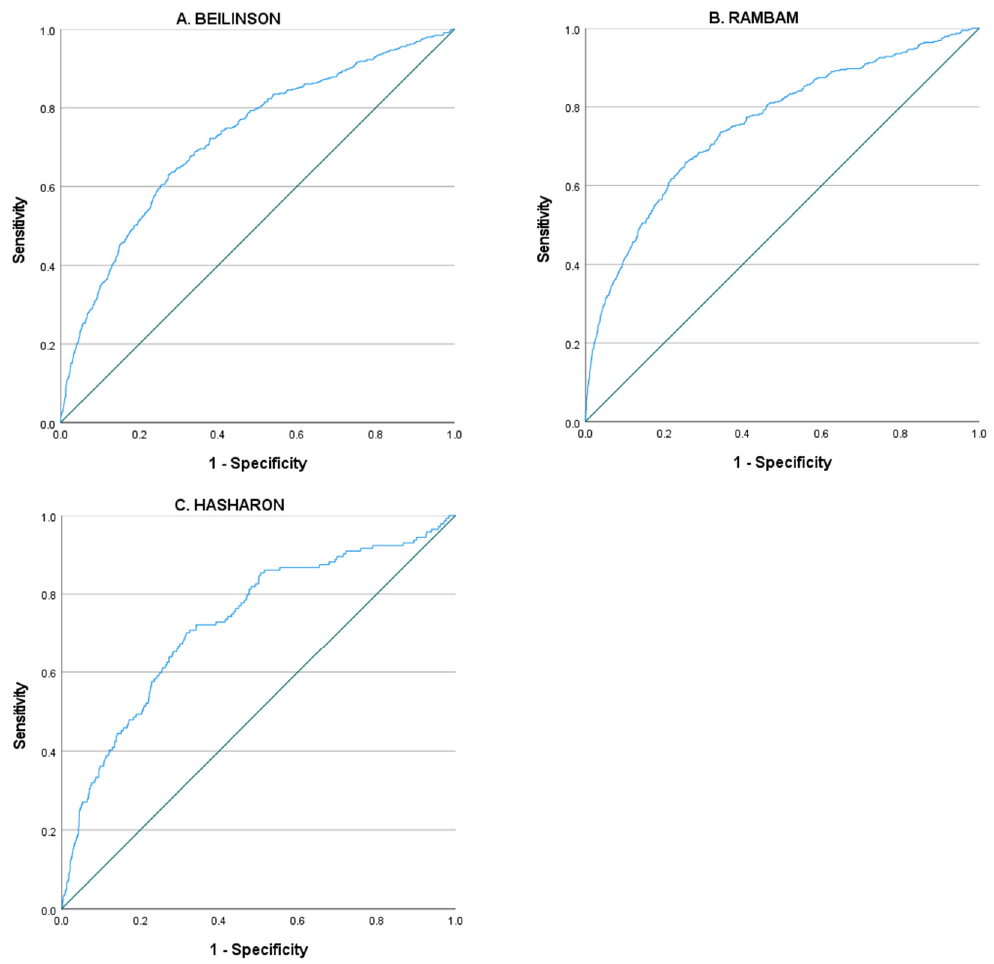
Figure 1. ROC curve of P (probability of antibiotic treatment as calculated by the logistic model